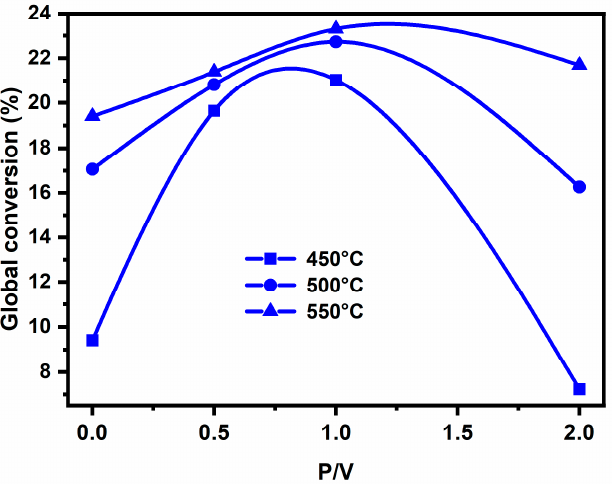
Figure 13. Conversion of propane depending on the reaction temperature and P/V ration in 3.6 wt% V 2 O 5 /ZrO 2 .